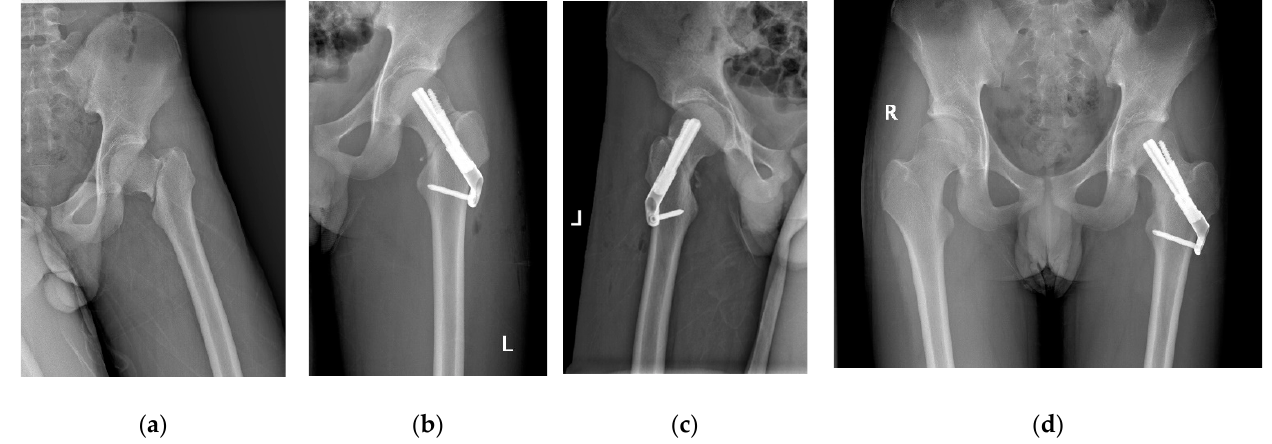
Figure 2. 14-year-old boy with left FNF treated with FNS. ( a ) Preoperative radiographs showing Delbet-III, Pauwels-III fracture; ( b,c ) postoperative radiographs; ( d ) outcome at 18 months postop- eration.